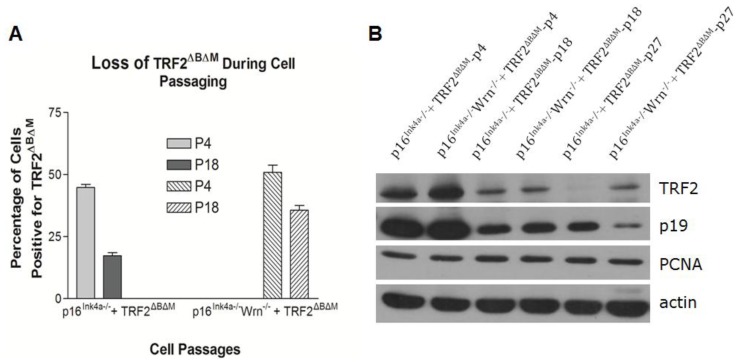
Elimination of TRF2ΔBΔM expression in the late passages of p16Ink4a−/− and p16Ink4a−/−Wrn−/− MEFs. (A) The percentage of cells positive for TRF2ΔBΔM measured by immunostaining; (B) Western blot showing the decrease of TRF2ΔBΔM expression with increasing cell passages.